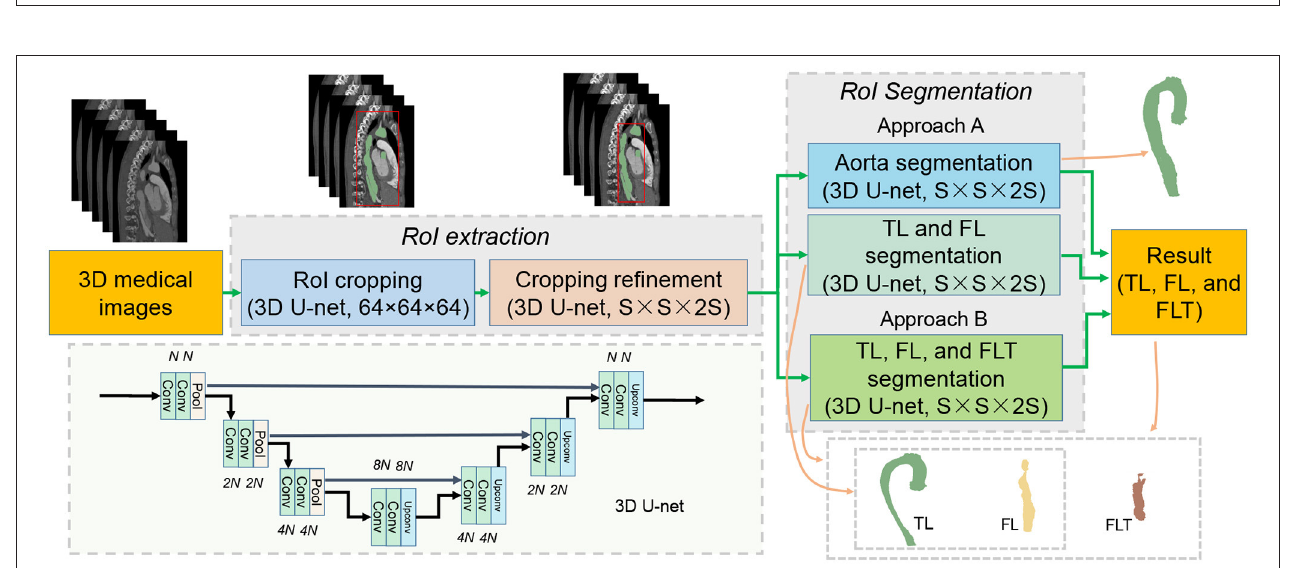
FIGURE 4 | Processing pipeline of the proposed baseline method. Best viewed in